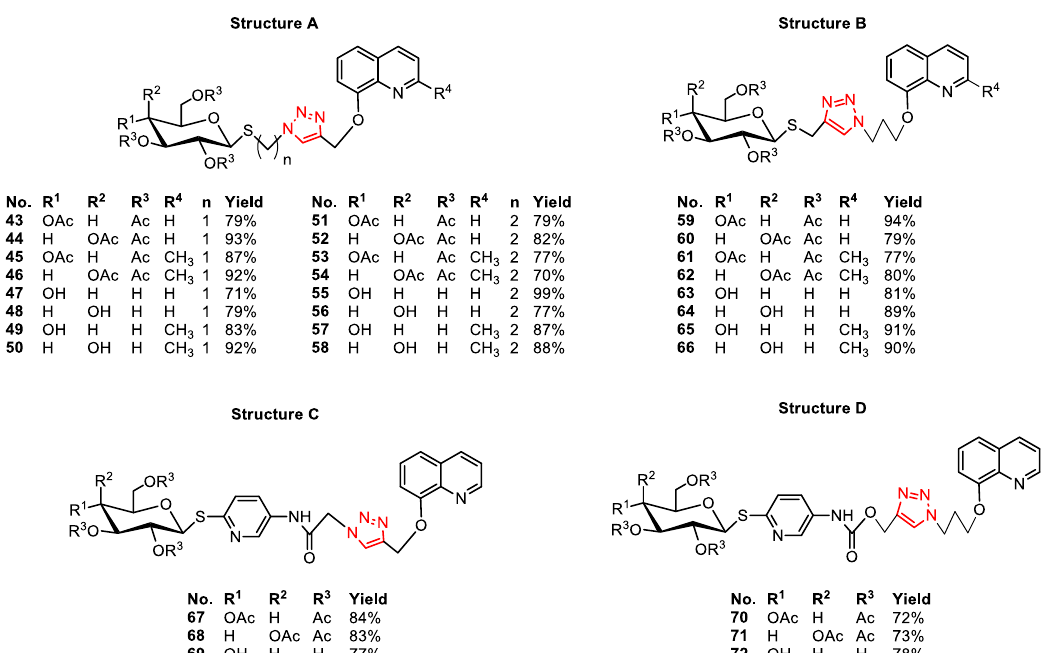
Figure 2. Structures and yields of obtained glycoconjugates 43 – 72 .